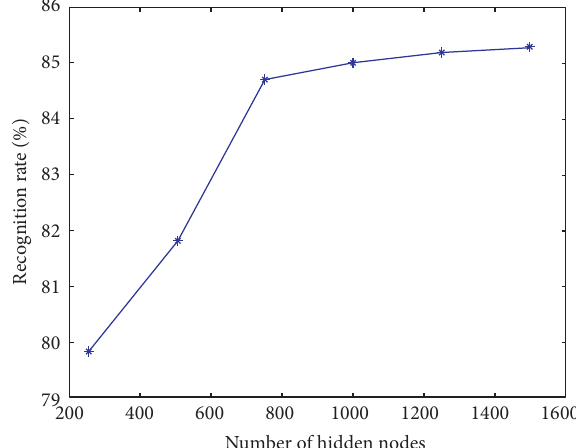
Figure 8: The influence of hidden node numbers to recognition rates in Fusion 2 .